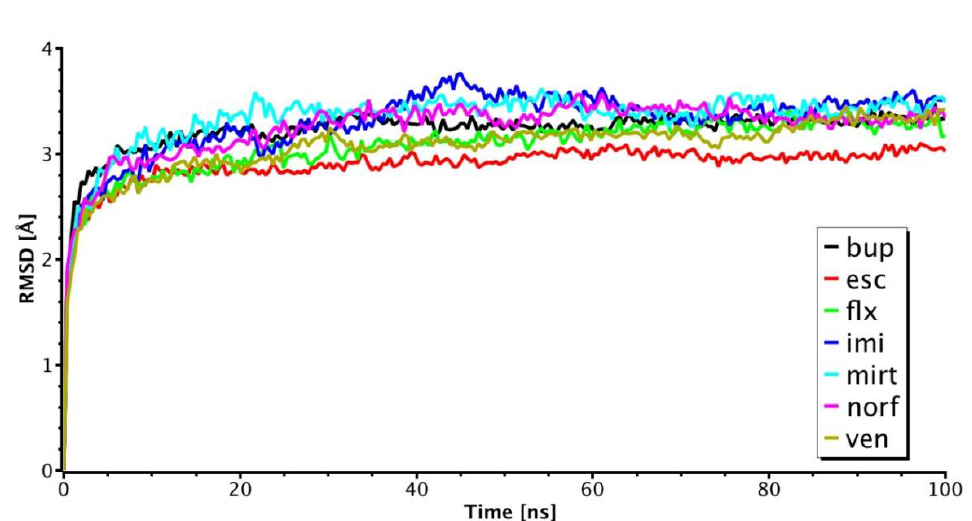
Figure 5. The RMSD plot for each antidepressant-receptor complex. bup, bupropion. esc, citalopram. flx, fluoxetine. imi, imipramine. mirt, mirtazapine. norf, norfluoxetine. ven, venlafaxine.